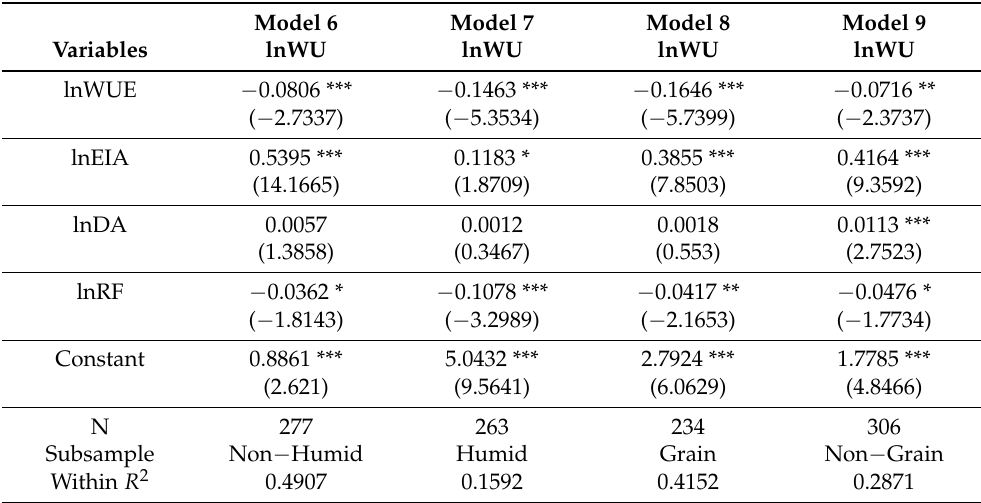
Table 4. Results of